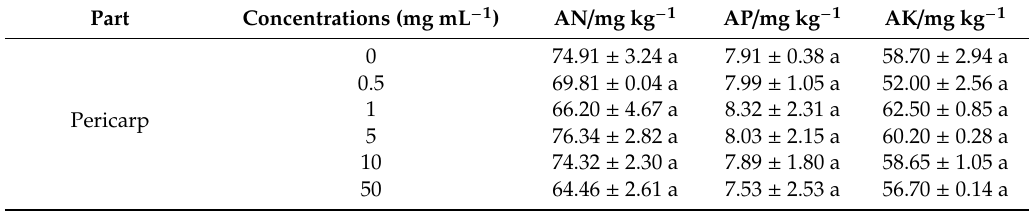
Table 1. AN, AP, and AK contents in the soil of L. formosana seedlings following treatment with different concentrations of aqueous extracts of C. migao pericarp, leaf, and rhizosphere soil.